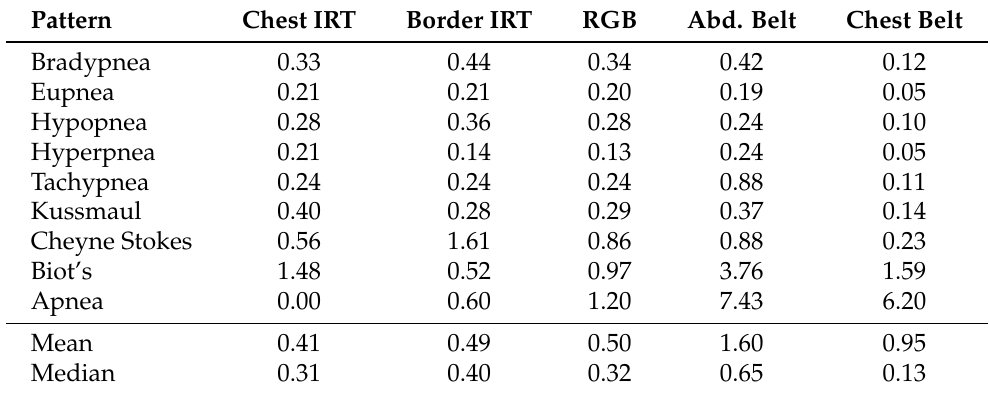
Table 2. Root-mean-square errors (RMSE) for the respiratory rate (RR) extraction of the different recorded breathing patterns and modalities. The unit of all values is in Breaths/min. Pattern Chest IRT Border IRT RGB